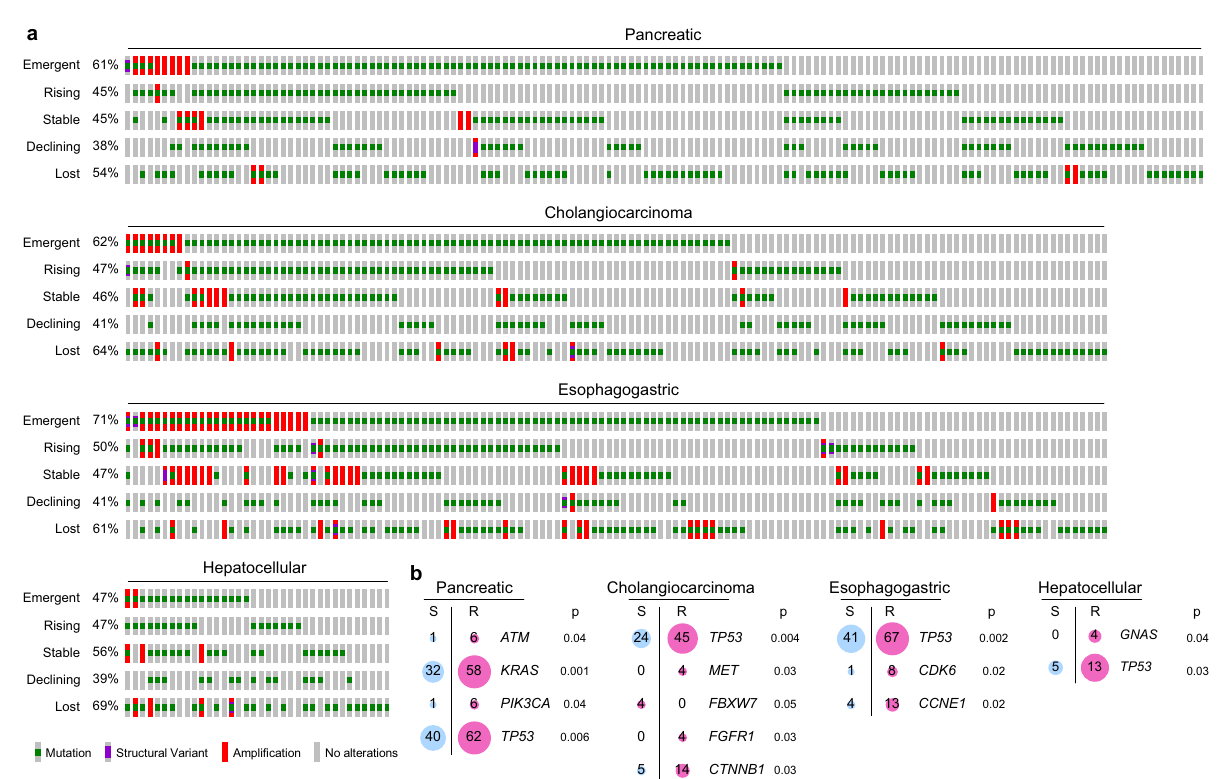
signi fi cant association ( p <0.05) based on two-sided Fisher exact tests are shown. Pinkandbluecirclesindicatethemajorityandminorityofalterationsfoundineach gene. For this exploratory analysis, no adjustments were made for multiple com- parisons. Values in circles show the number of patients with ctDNA